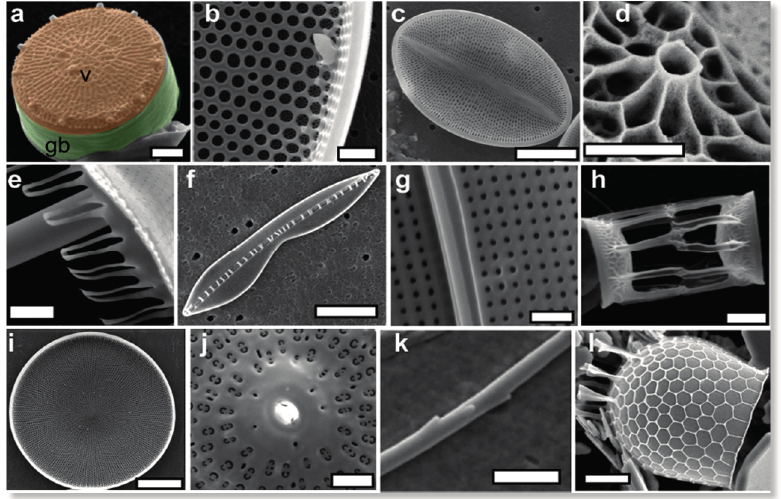
Figure 1. Morphological diversity in diatoms frustule. Colored areas in ( a ) show valve (v) and girdle band (gb). Scale bar ( a , k ) 1 µm; ( b ) 5 μ m; ( c , f , l ) 10 μ m; ( d ) 500